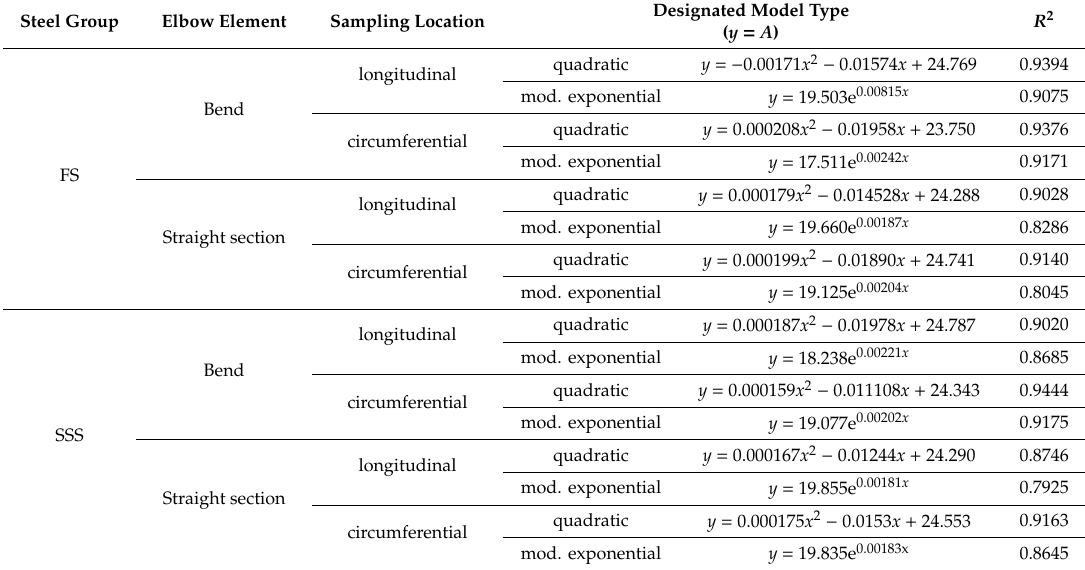
Table 5. Summary set of prognostic models of elongation for FS and SSS steel